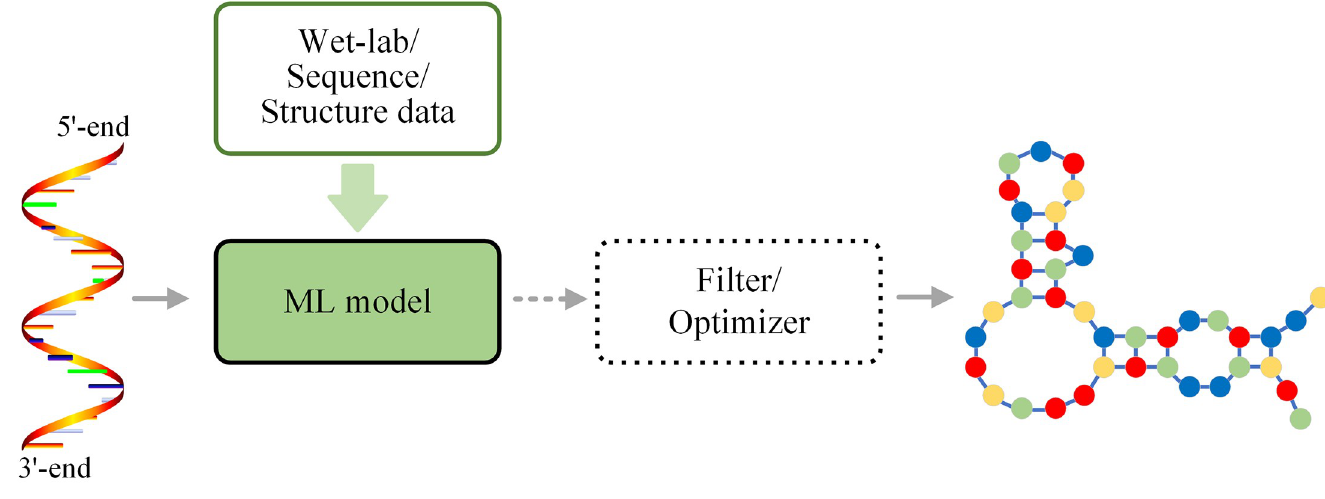
Fig 4. Framework for the RNA secondary structure prediction methods with ML-based prediction process. ML models (trained by wet lab, RNA sequence, or RNA structure data) are directly used to predict RNA secondary structures in an end-to-end way or followed by a filter or optimizer to obtain the optimal RNA secondary